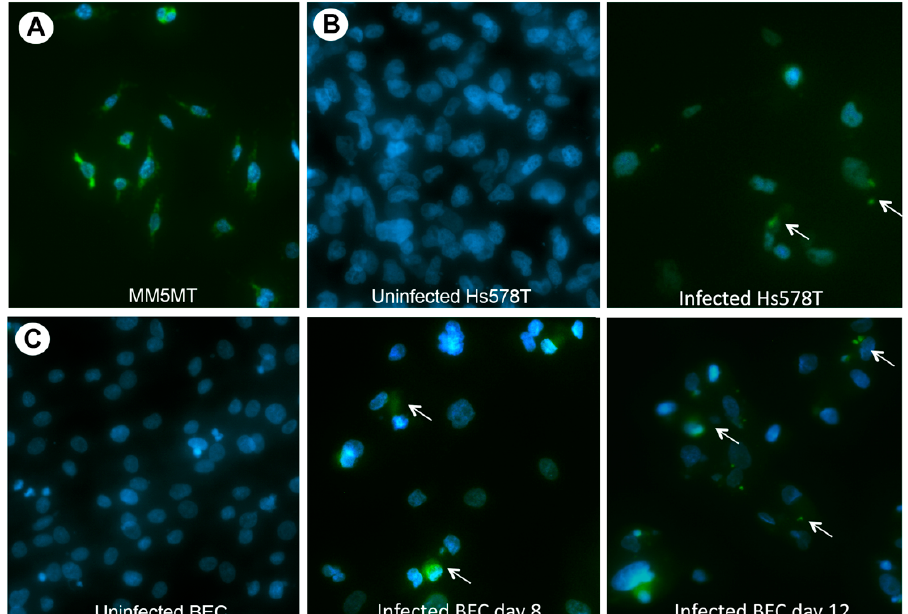
Figure 2. Dark field microscopy showing betaretrovirus RNA by in situ hybridization (green signal) ( A ) MMTV RNA in the MM5MT murine breast cancer cells (control), ( B ) HBRV in the cytoplasm of Hs578T following co-culture with PBC conditioned media and ( C ) HBRV signal in biliary epithelial cells infected with lymph node conditioned Hs578T supernatants [white arrows indicative of HBRV RNA, DAPI blue stain for nuclei, magnification ×200].